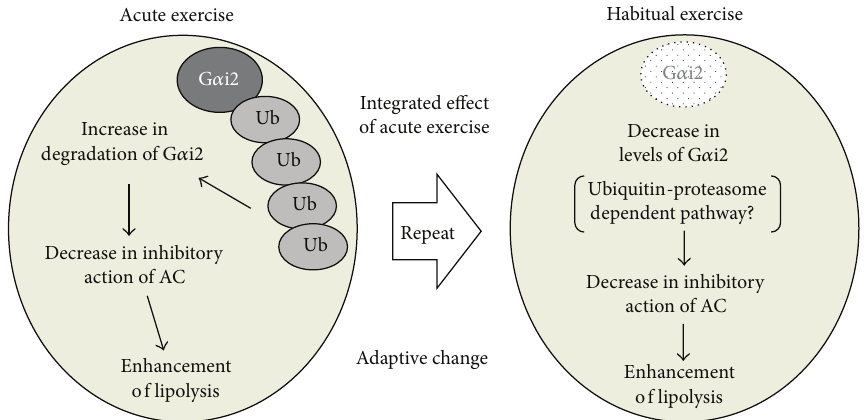
Figure 5: In white adipocytes, acute exercise accelerates the degradation of G 𝛼 i2 proteins through the ubiquitin-proteasome system during, and at least 3 hours after, exercise. This mechanism might become a trigger for habitual decreases in the levels of G 𝛼 i2 by ET.